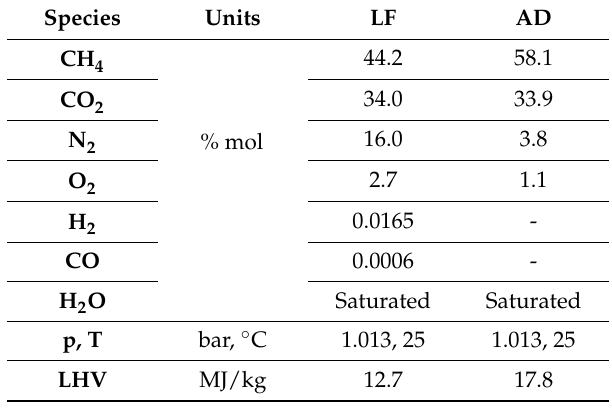
Table 1. Investigated biogas compositions. LF: landfill; AD: anaerobic